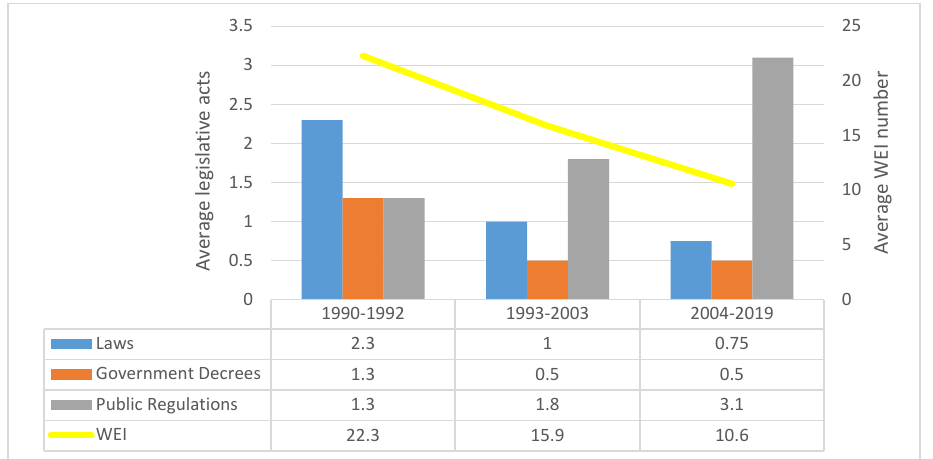
Fig. 4: Changes in legislative acts (average per year) and Water Exploitation Index (WEI)